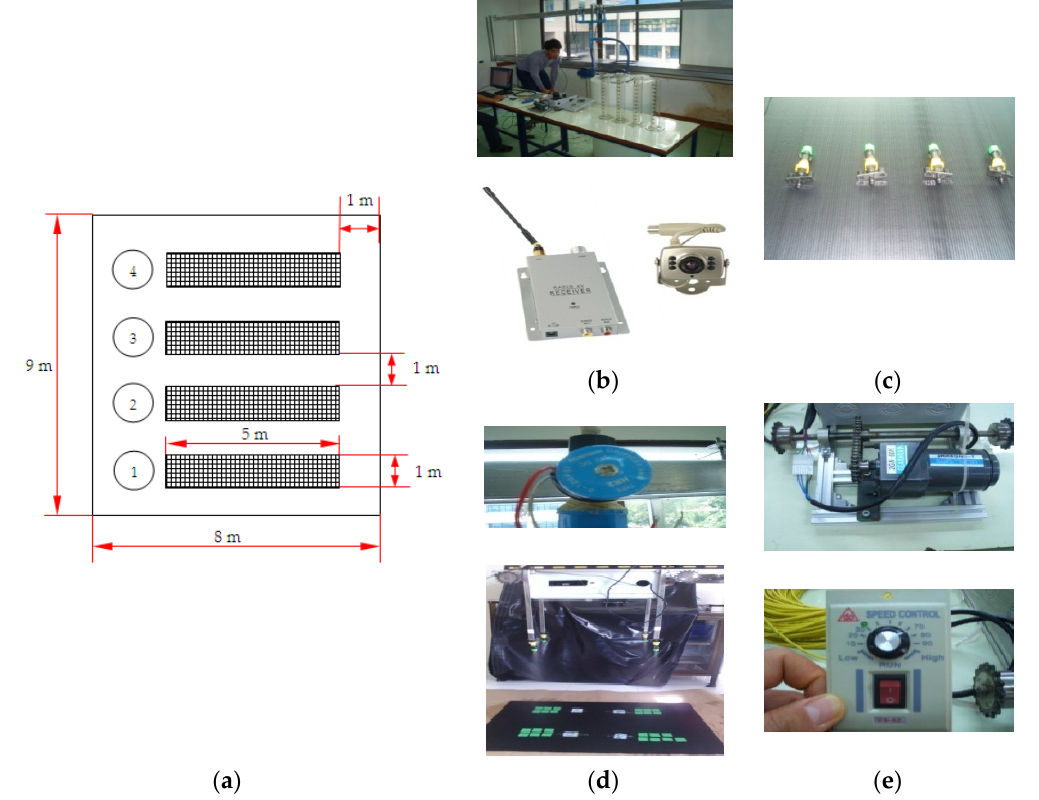
Figure 3. Specifications of the variable rate application spraying system: ( a ) Experimental layout of orchids inside the greenhouse; ( b ) A double row bar with a carrier controller and wireless WebCAM with a receiver; ( c ) Microcontroller with various sensors and nozzles; ( d ) Solenoid valve; ( e ) Gear motor and voltage adapter (220 VAC to 24 VDC, 5 A).